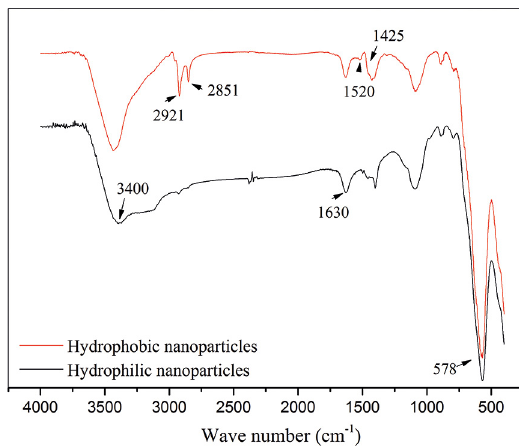
Figure 8. FTIR spectra of the magnetic nanoparticles.